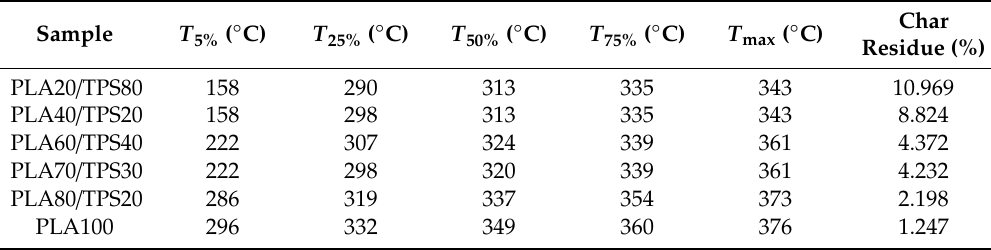
Table 3. Thermal degradation temperature of PLA100 and PLA / TPS blend